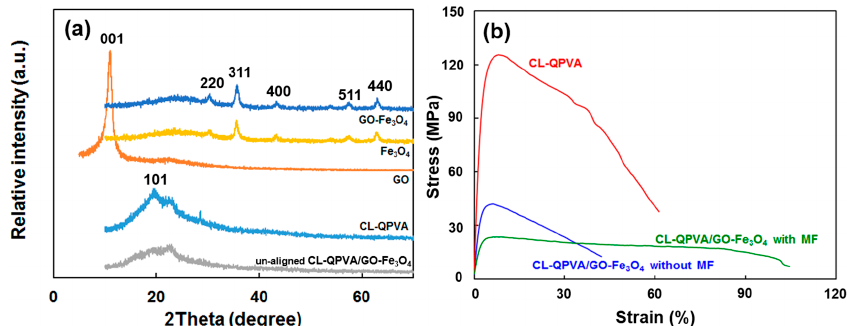
Figure 2. ( a ) X-ray diffraction (XRD) patterns of graphene oxide (GO), iron oxide (Fe 3 O 4 ), graphene oxide-iron oxide (GO-Fe 3 O 4 ), CL-QPVA and un-aligned CL-QPVA/GO-Fe 3 O 4 membranes; and ( b ) stress–strain curves of the CL-QPVA and CL-QPVA/GO-Fe 3 O 4 composites prepared with and without the magnetic field (MF).